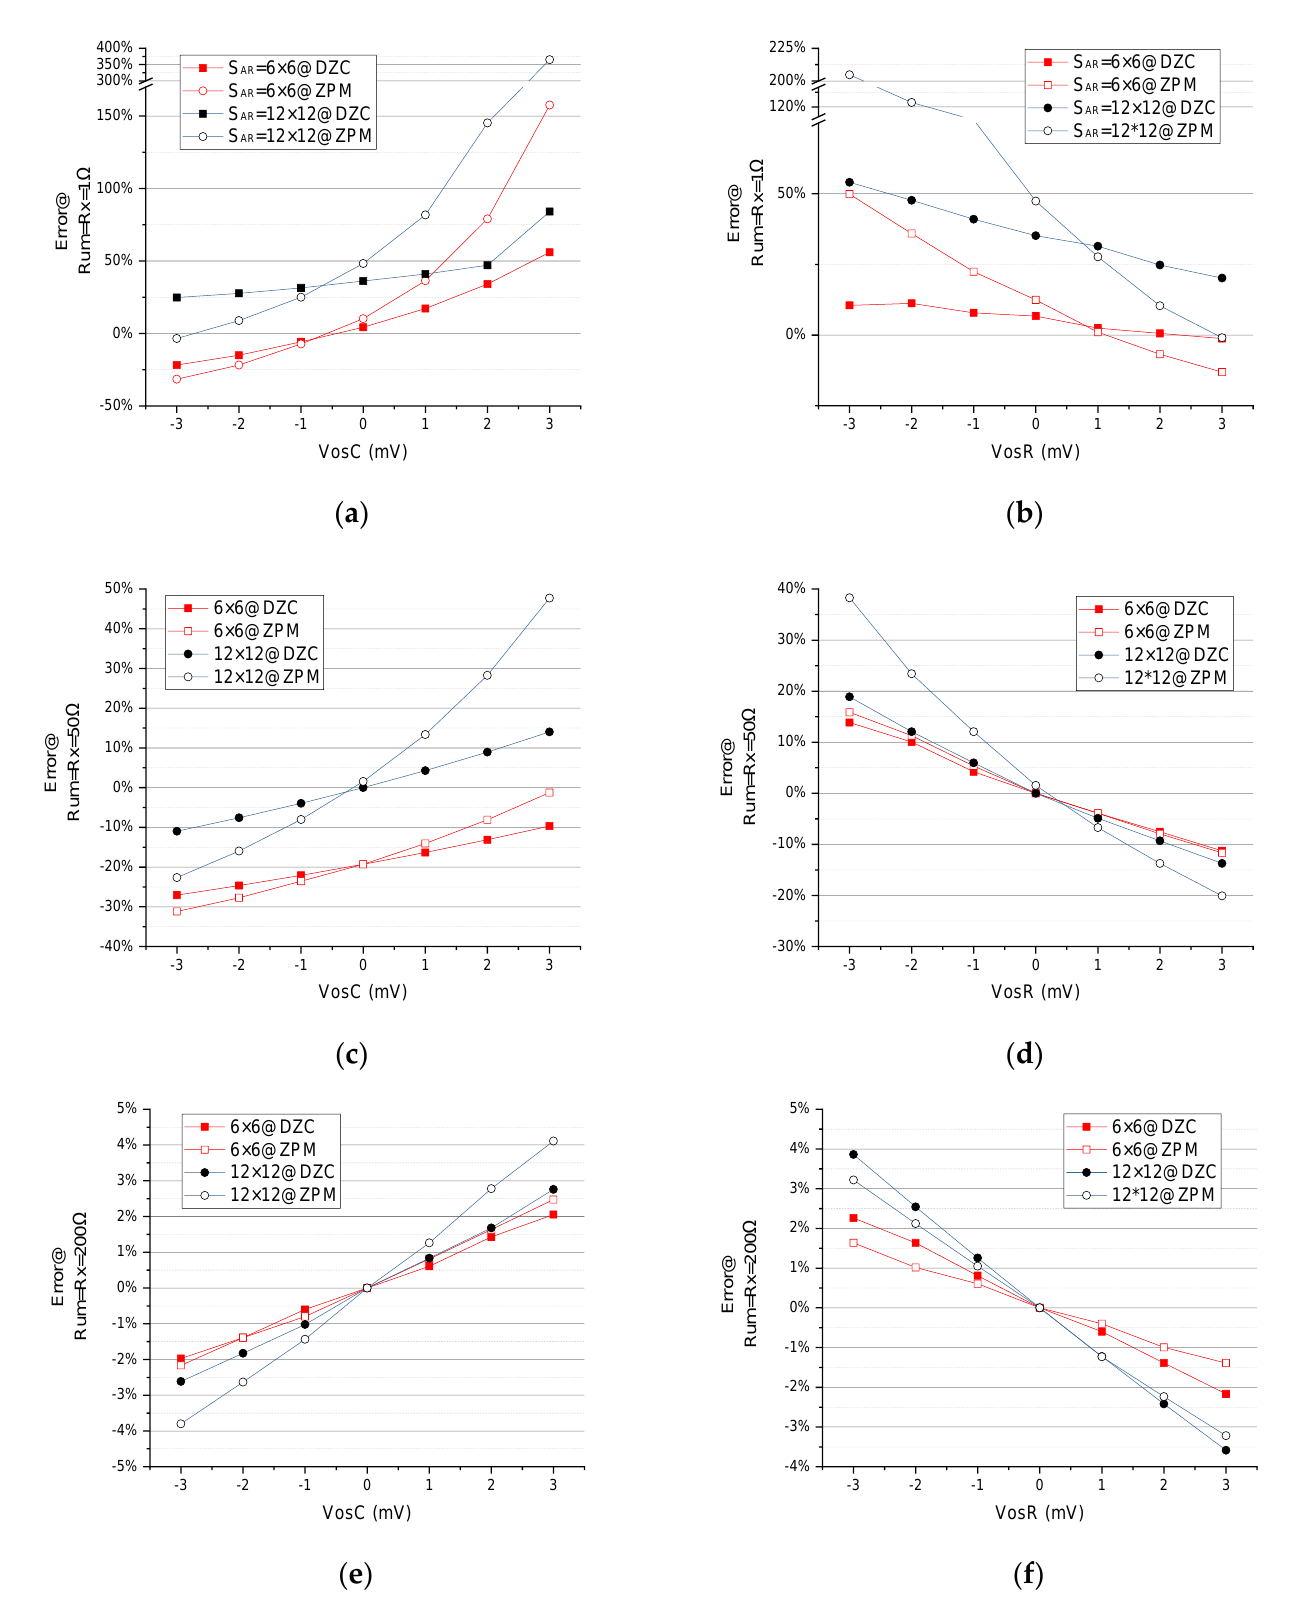
Figure 11. The effect of ( a , c , e ) 𝑣 𝑜𝑠𝐶 and ( b , d , f ) 𝑣 𝑜𝑠𝑅 on measurement error of different 𝑆 𝐴𝑅 = Figure 11. The effect of ( a , c , e ) v osC and ( b , d , f ) v osR on measurement error of different S AR = 6 × 6, 12 × 12 when 𝑅 = 𝑅 = 1 Ω, 50 Ω, 200 Ω (EXP D). 6 × 6, 12 × 12 when R x = R um = 1 Ω , 50 Ω , 200 Ω (EXP 𝑥 𝑢𝑚